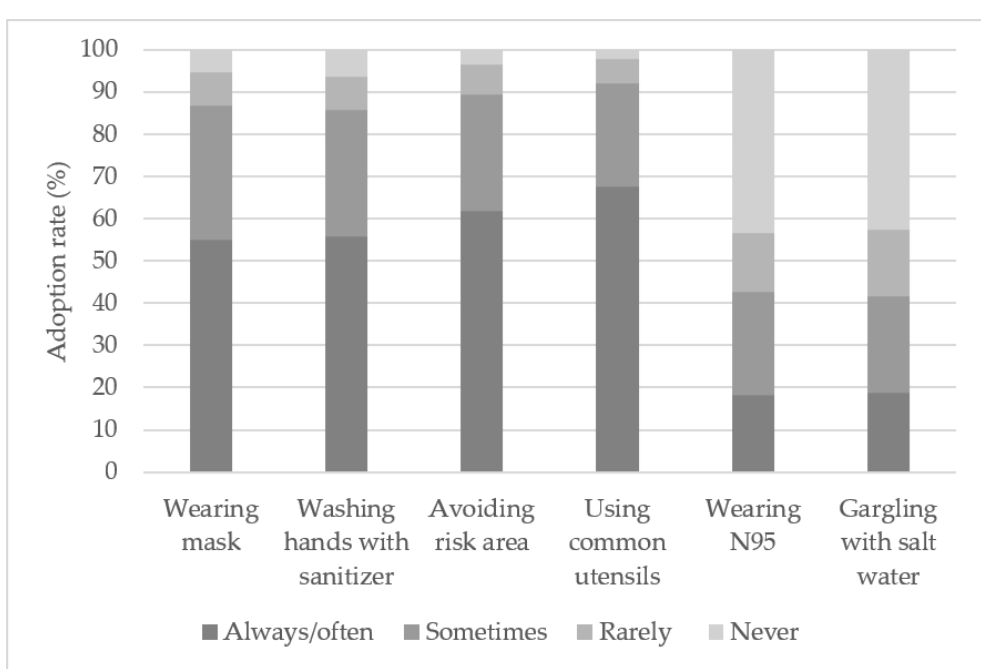
Figure 1. The prevalence of personal protective measures adoption against coronavirus disease 2019 (COVID-19). N95: A mask that filters at least 95% of airborne particles.